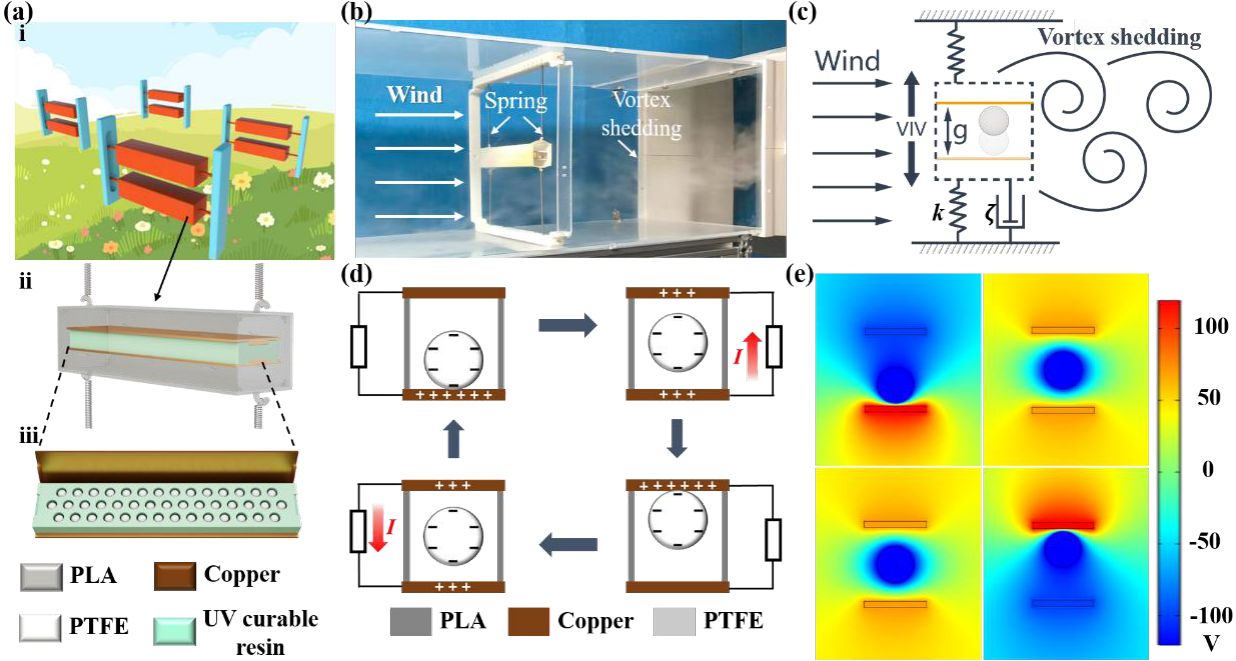
Figure 1. Design and working mechanism of the SC − TENG. ( a ) Schematic diagram and structure of the SC − TENG: ( i ) application scenario of the SC − TENG, ( ii ) structure of the SC − TENG, ( iii ) detailed structure of the power generation unit; ( b ) experimental setup in the wind tunnel; ( c ) vortex-induced vibration of the SC − TENG; ( d ) four working states in the process of power generation; ( e ) potential simulation diagrams of four working states.